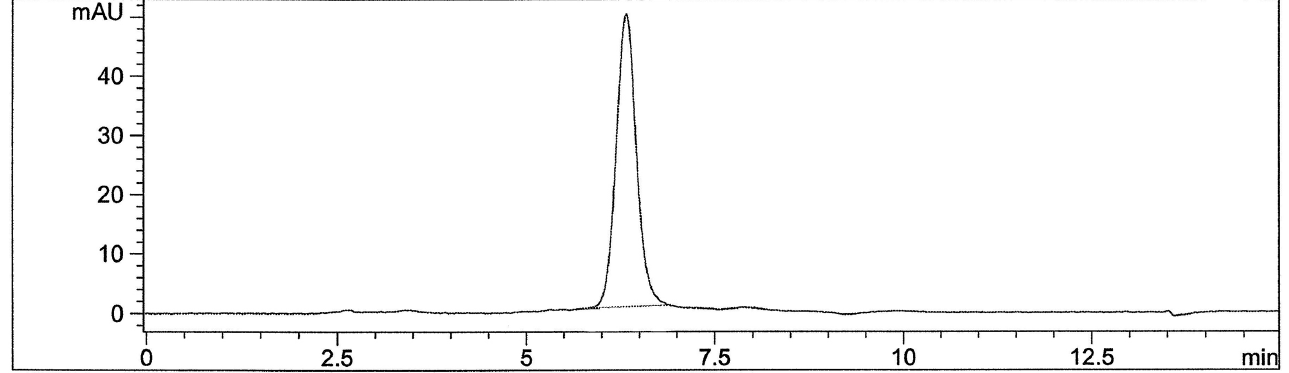
FIGURE 2 - Chromatogram of a solution of analytical standard of Nystatin [205 IU.mL -1 ] (refer to Chromatographic Conditions ).